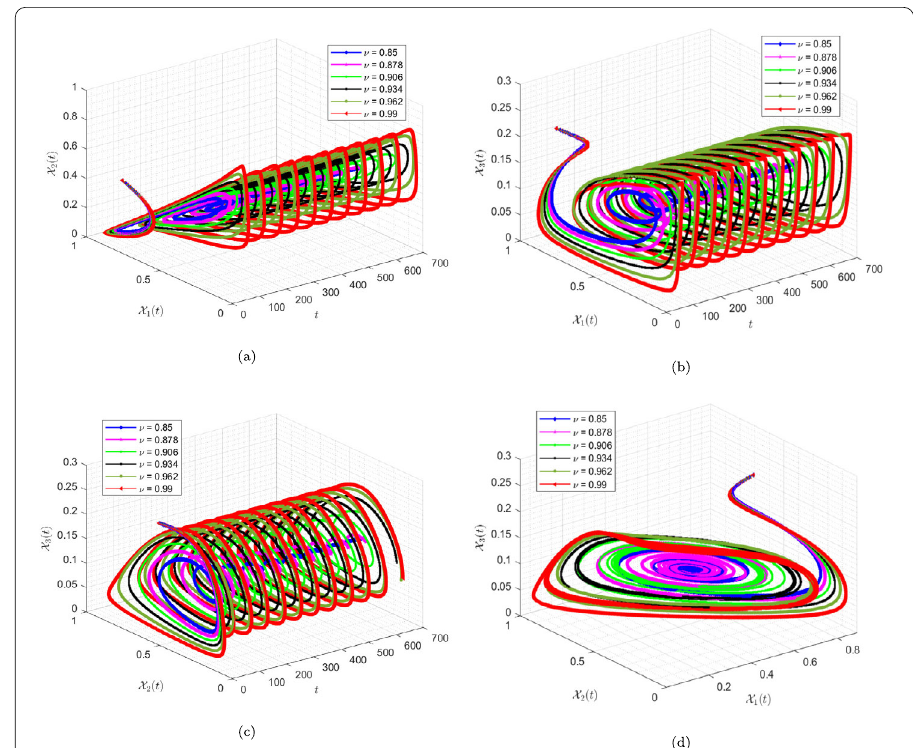
Figure 4 Dynamics for system (19) for different parameters in